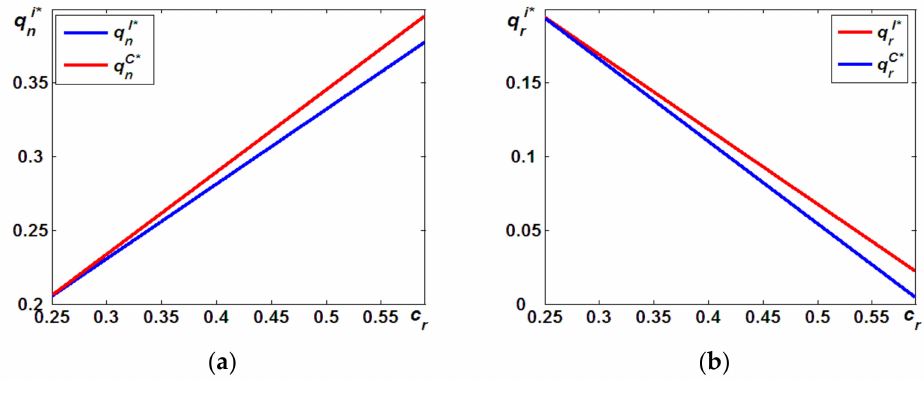
Figure 2. Differences in optimal quantities: (a) q I ∗ n vs. q C ∗ n ; ( b ) q I ∗ r vs. q C ∗ r .